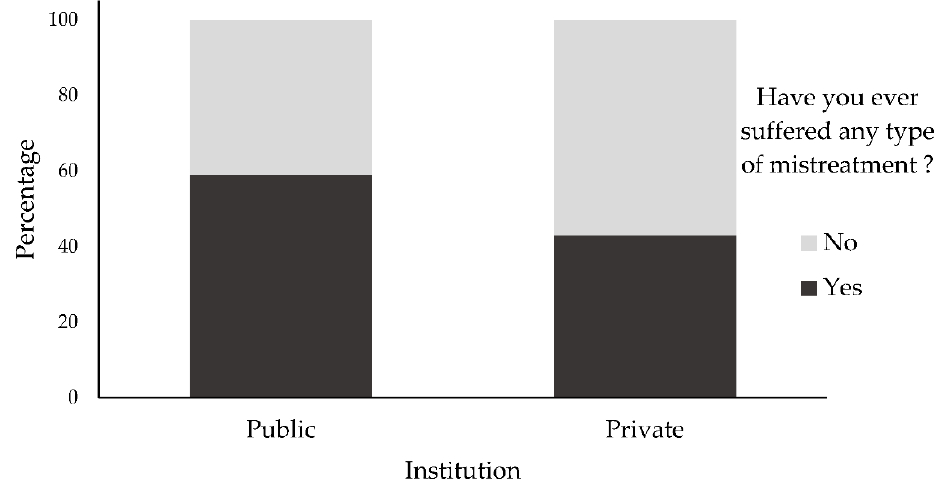
Figure 1. Frequency distribution of the responses of the research participants in relation to having already suffered some type of mistreatment, by institution. Source: Own elaboration.